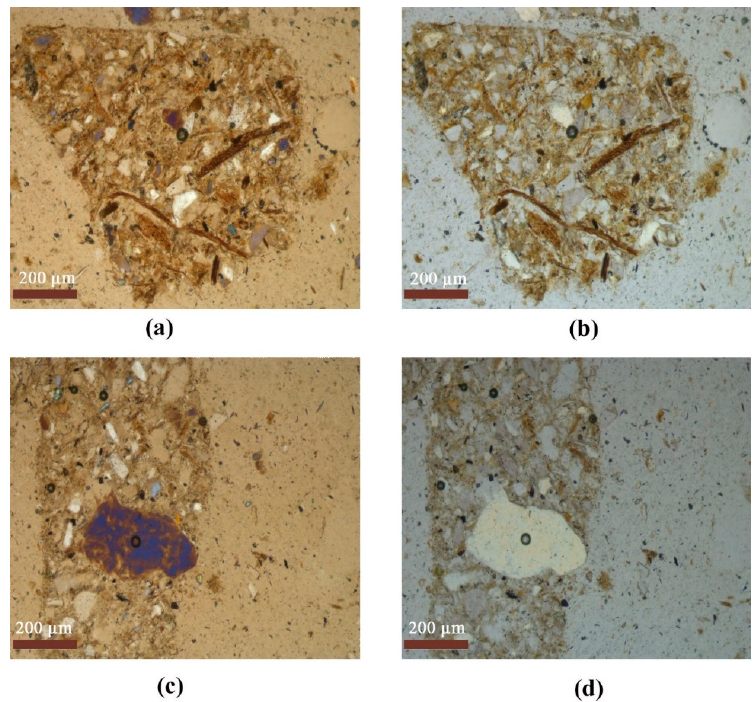
Figure 12. Biogenic aggregate ( a , b ) and aggregate with quartz ( c , d ). S 3 (25–31 cm) ( a , c ) Plane polarized light; ( b , d ) crossed polarized light.